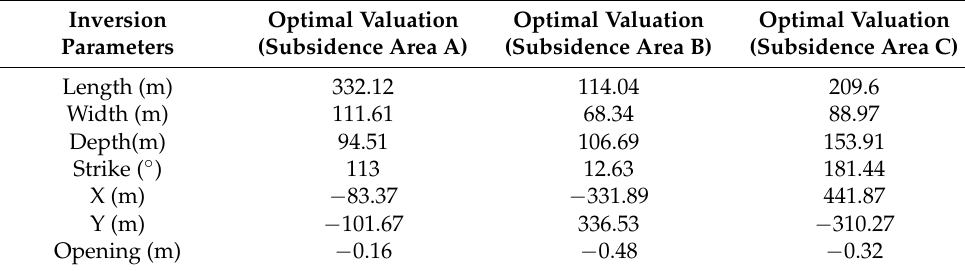
Table 2. Optimal fitting parameters of the Okada